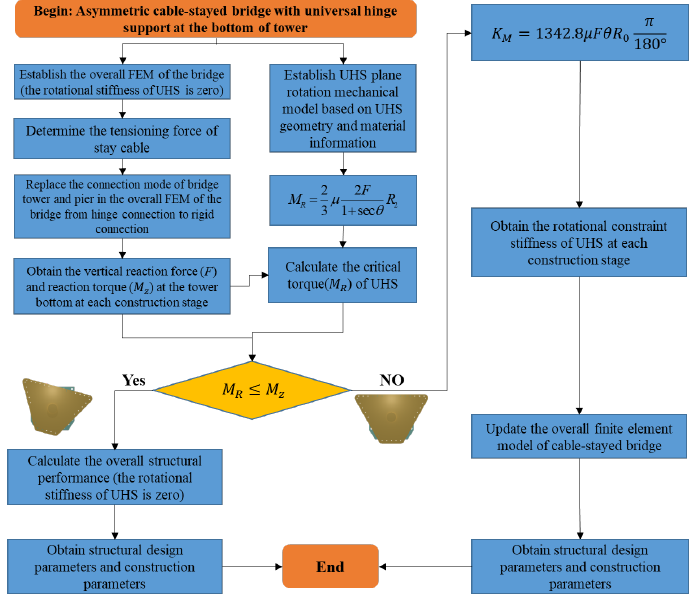
Figure 14. Calculation procedure of the cable-stayed bridge with UHS.